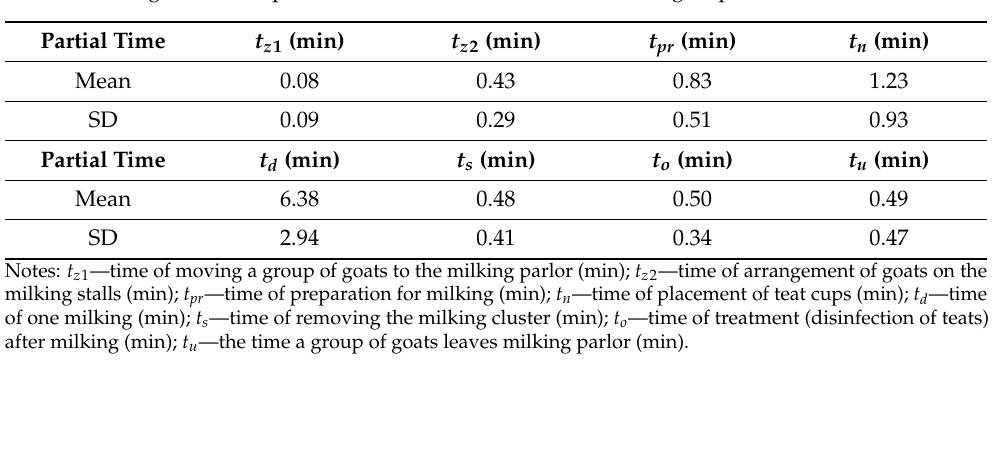
Table 2. Average values of partial times of the time schedule for all